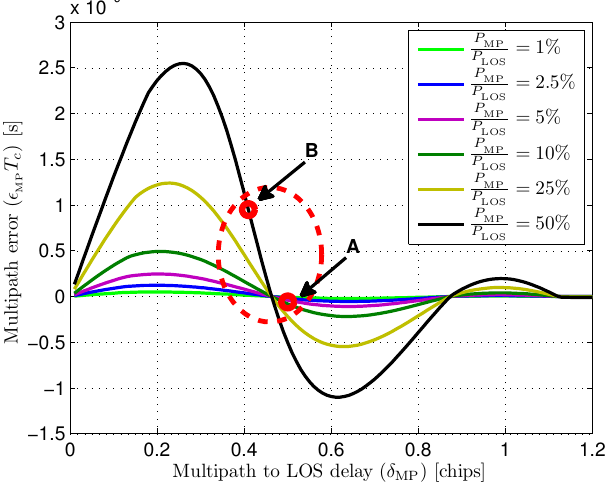
T ) as a function of the delay between LOS and NLOS c MP = 25 MHz). c